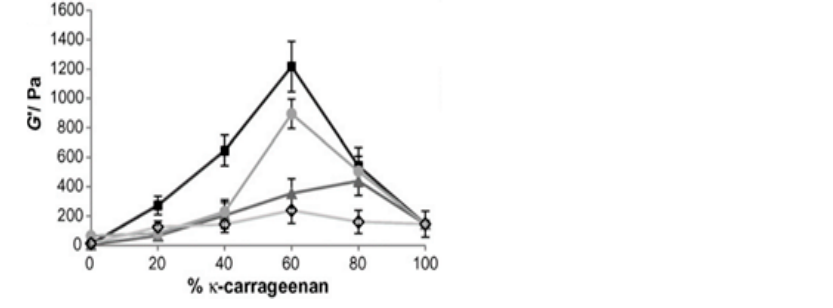
Figure 4. G’ elastic component of galactomannan/ κ -carrageenan mixed gels (guar gum ( ); locust bean gum ( ■ ); Gleditsia triacanthos galactomannan ( ♢ ) and Sophora japonica galactomannan ( )) [117].